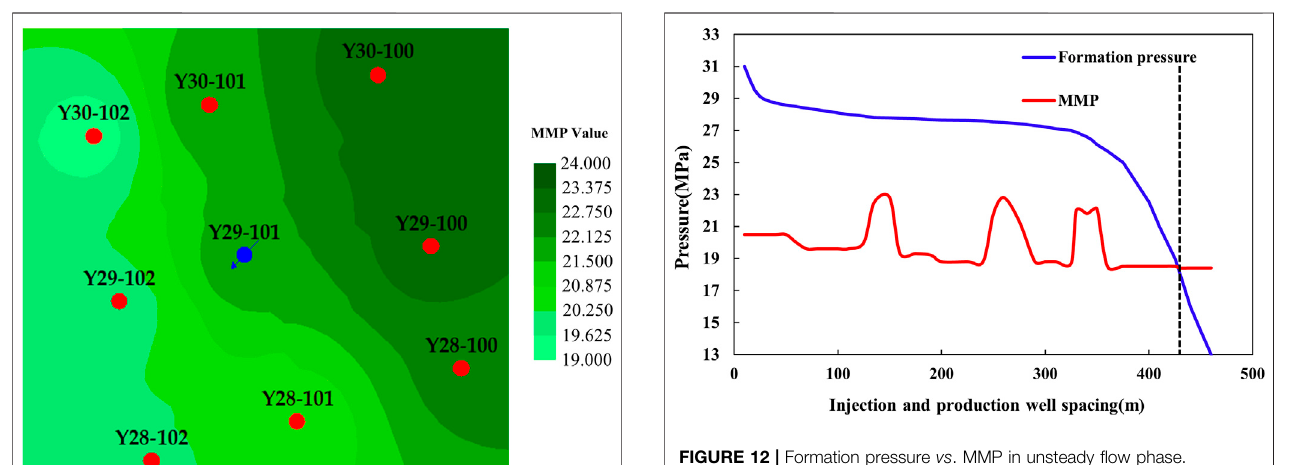
FIGURE 12 | Formation pressure vs . MMP in unsteady fl ow